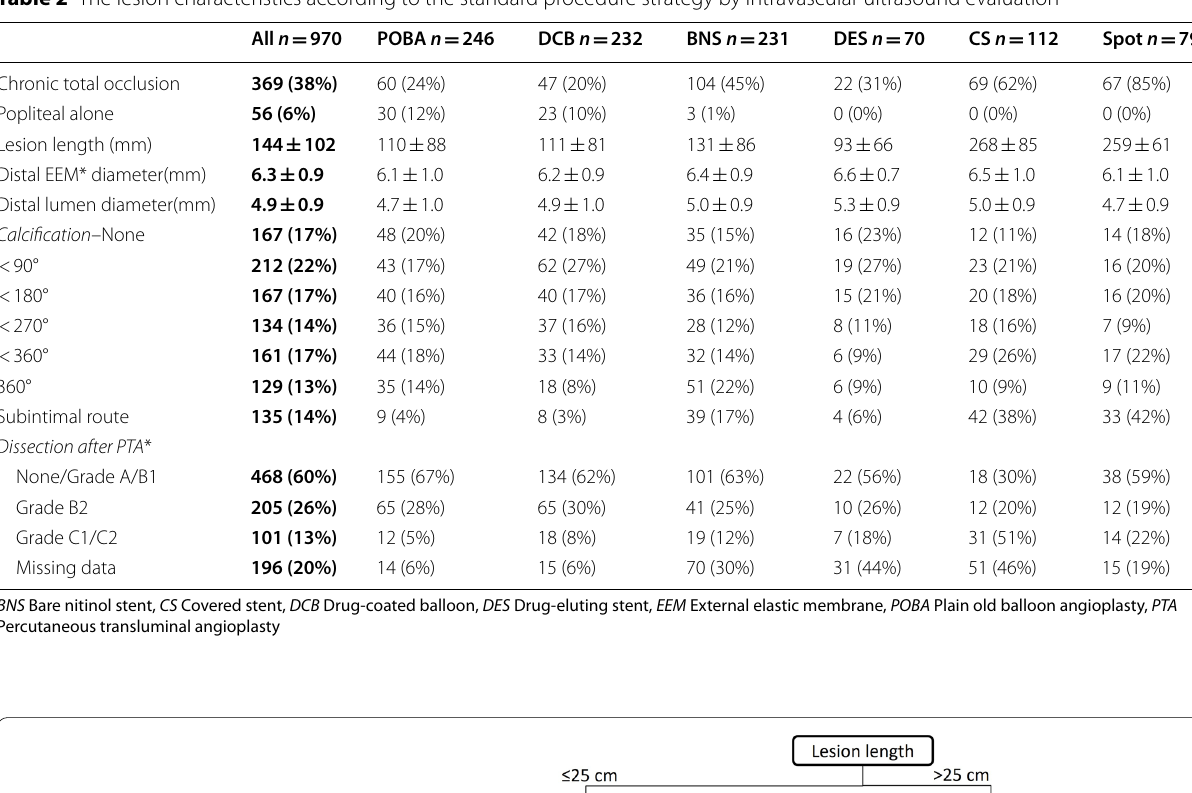
Table 2 The lesion characteristics according to the standard procedure strategy by intravascular ultrasound evaluation